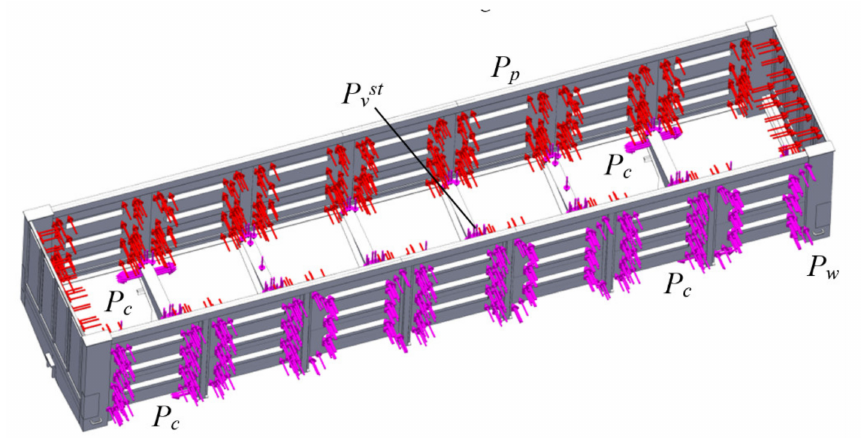
Figure 11. Design diagram of an open car body.